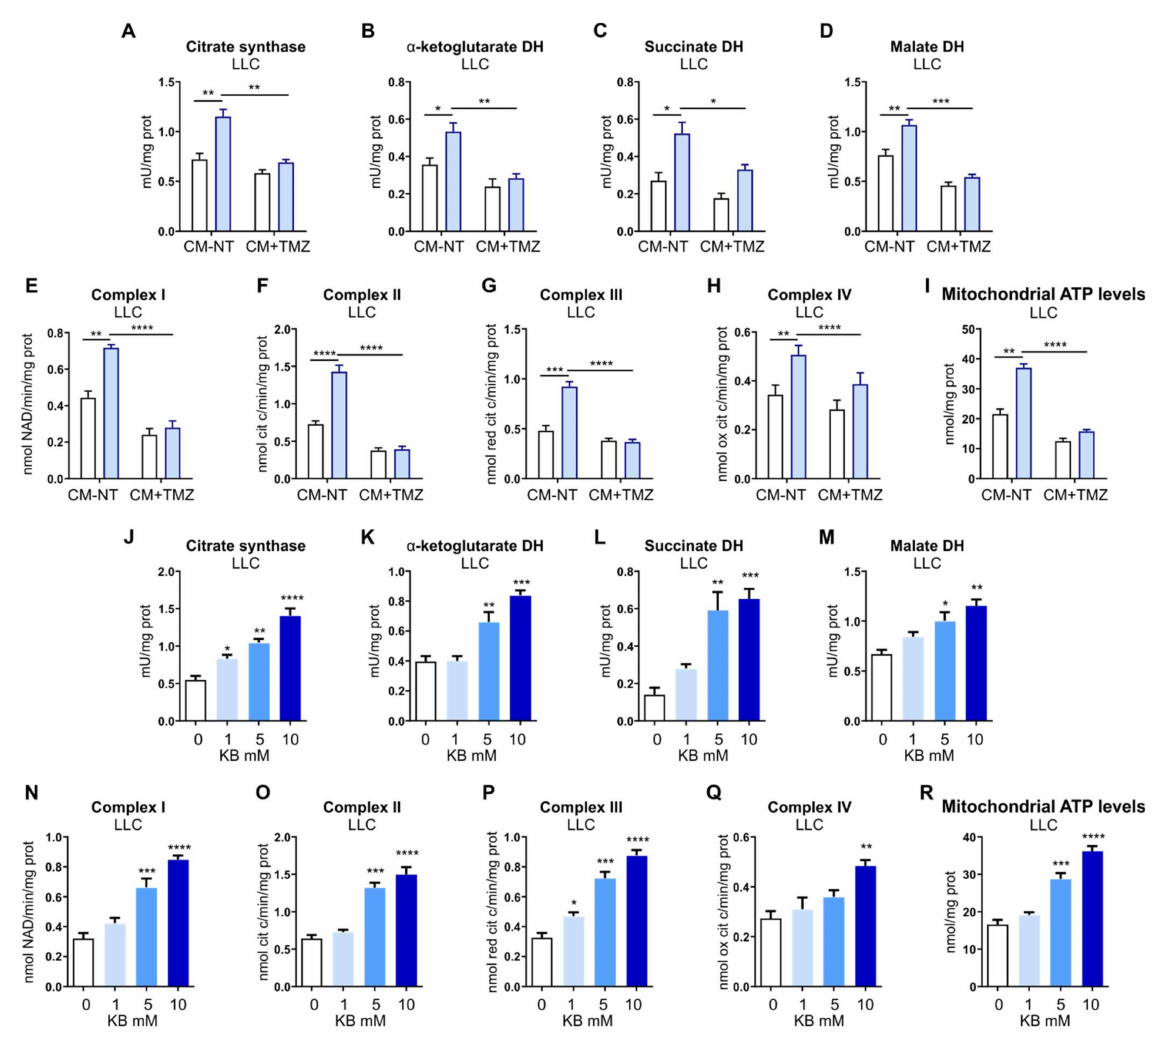
Figure 6. Endothelial-derived KBs are involved in CCs metabolic rewiring. ( A – H ) Activities of TCA cycle enzymes citrate synthase, α -ketoglutarate DH, succinate DH and malate DH, and mitochondrial ETC complexes I–IV in LLC cells treated for 24 h with FLVCR1a -silenced (light blue) or control (white) BTECs-derived CM, under basal conditions (CM-NT) or following BTECs treatment with 500 µ M trimetazidine (CM + TMZ). Data are expressed as mU/mg mitochondrial proteins for TCA enzymes, nmol NAD+/min/mg of mitochondrial protein for complex I, nmol reduced cytochrome c/min/mg of mitochondrial protein for complexes II–III, and nmol oxidized cytochrome c/min/mg of mitochondrial protein for complex IV. Data represent means ± SEM, n = 3. For statistical analyses, two-way ANOVA test with Tukey’s multiple comparisons was used. * p < 0.05, ** p < 0.01, *** p < 0.001, **** p < 0.0001. ( I ) Mitochondrial ATP levels were measured with a bioluminescent assay kit in LLC cells treated for 24 h with FLVCR1a -silenced (light blue) or control (white) BTECs-derived CM, under basal conditions (CM-NT) or following BTECs treatment with 500 µ M trimetazidine (CM + TMZ). Results are expressed as nmol/mg of mitochondrial proteins. Data represent means ± SEM, n = 3. For statistical analyses, two-way ANOVA test with Tukey’s multiple comparisons was used. ** p < 0.01, **** p < 0.0001. ( J – Q ) Activities of TCA cycle enzymes citrate synthase, α -ketoglutarate DH, succinate DH and malate DH, and mitochondrial ETC complexes I–IV in LLC cells treated for 24 h with increasing concentration of β -OH, i.e., 1, 5 and 10 mM. Data are expressed as mU/mg mitochondrial proteins for TCA enzymes, nmol NAD+/min/mg of mitochondrial protein for complex I, nmol reduced cytochrome c/min/mg of mitochondrial protein for complexes II–III, and nmol oxidized cytochrome c/min/mg of mitochondrial protein for complex IV. Data represent means ± SEM, n = 3. For statistical analyses, an ordinary one-way ANOVA test with Dunnett’s multiple comparisons test was used. * p < 0.05, ** p < 0.01, *** p < 0.001, **** p < 0.0001. ( R ) Mitochondrial ATP levels were measured with a bioluminescent assay kit in LLC cells treated for 24 h with increasing concentrations of β -OH, i.e., 1, 5, and 10 mM. Results are expressed as nmol/mg of mitochondrial proteins. Data represent means ± SEM, n = 3. For statistical analyses, an ordinary one-way ANOVA test with Dunnett’s multiple comparisons was used. *** p < 0.001, **** p <